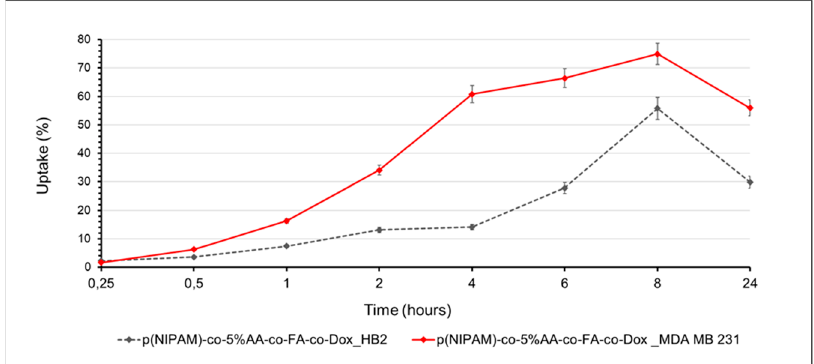
Figure 9. Uptake percentage of p(NIPAM)-co-5%AA-co-FA-co-Dox (doxorubicin conjugated